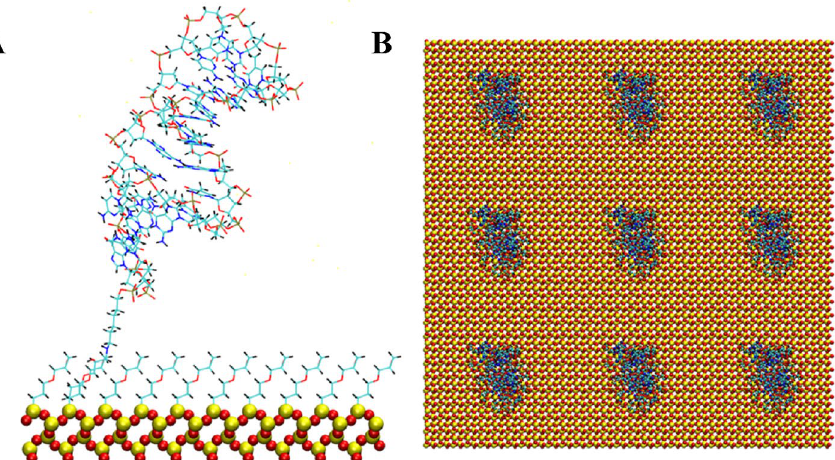
Figure 5. Anti MUC1 aptamer tethered to SiO 2 biosensor substrate in configuration 4 (3 ′ end attachment, perpendicular to surface, low density) ( A ) Side view of simulation cell ( B ) Top view with periodic display. Water and ion molecules are not